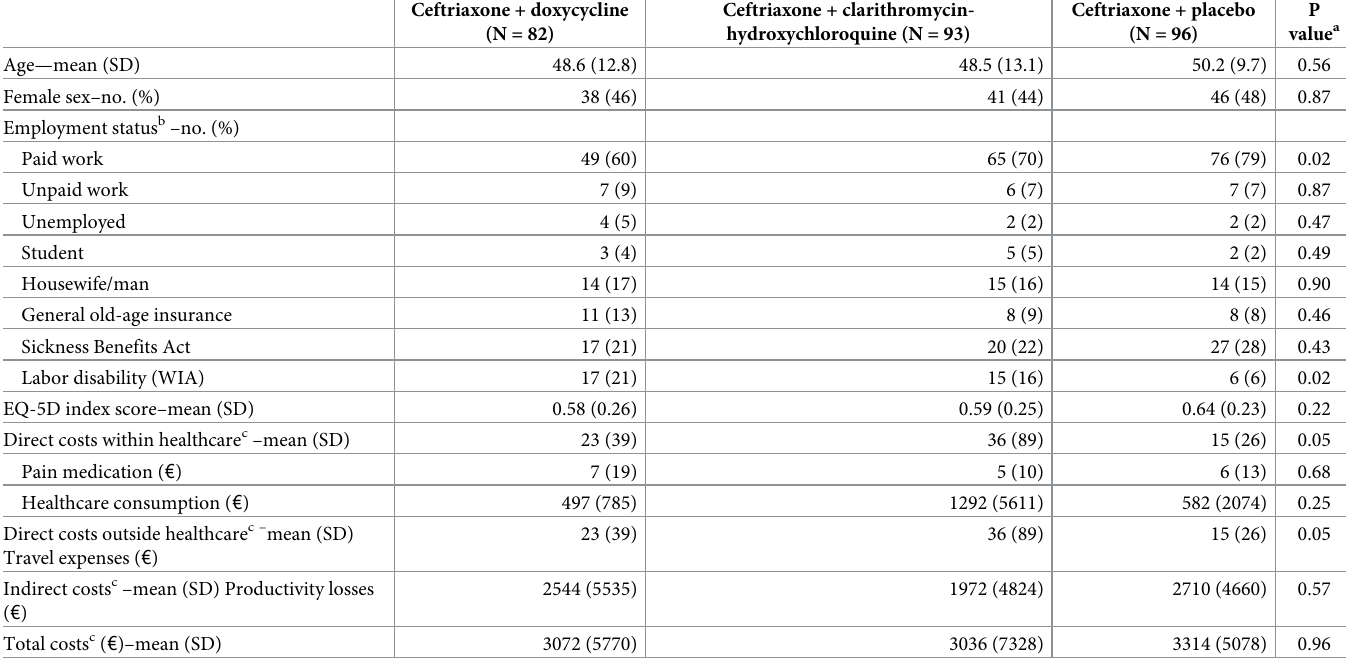
Table 1. Baseline